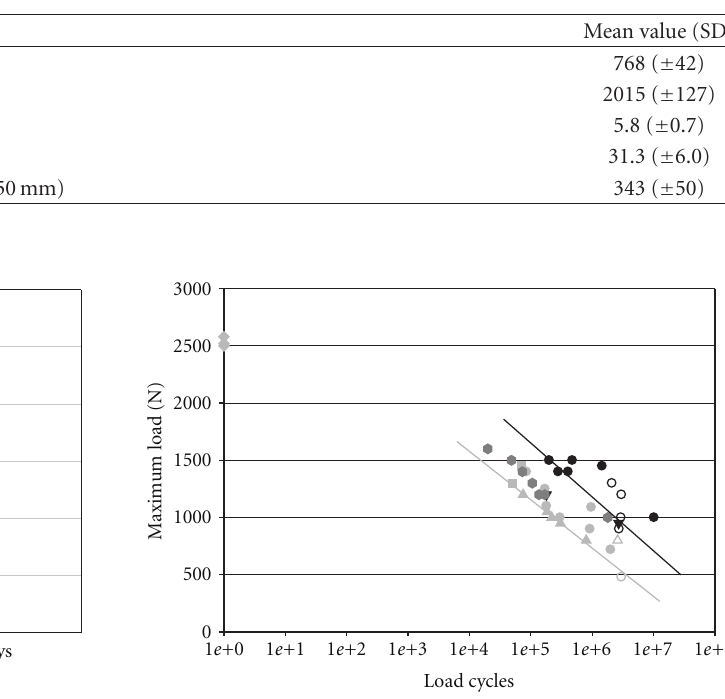
Figure 5: Ultimate tensile strength of the artificial ligament fixed in the block.